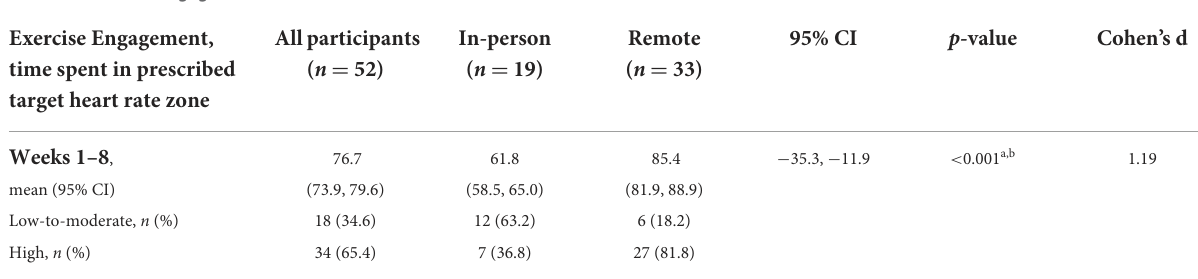
TABLE 6 Exercise